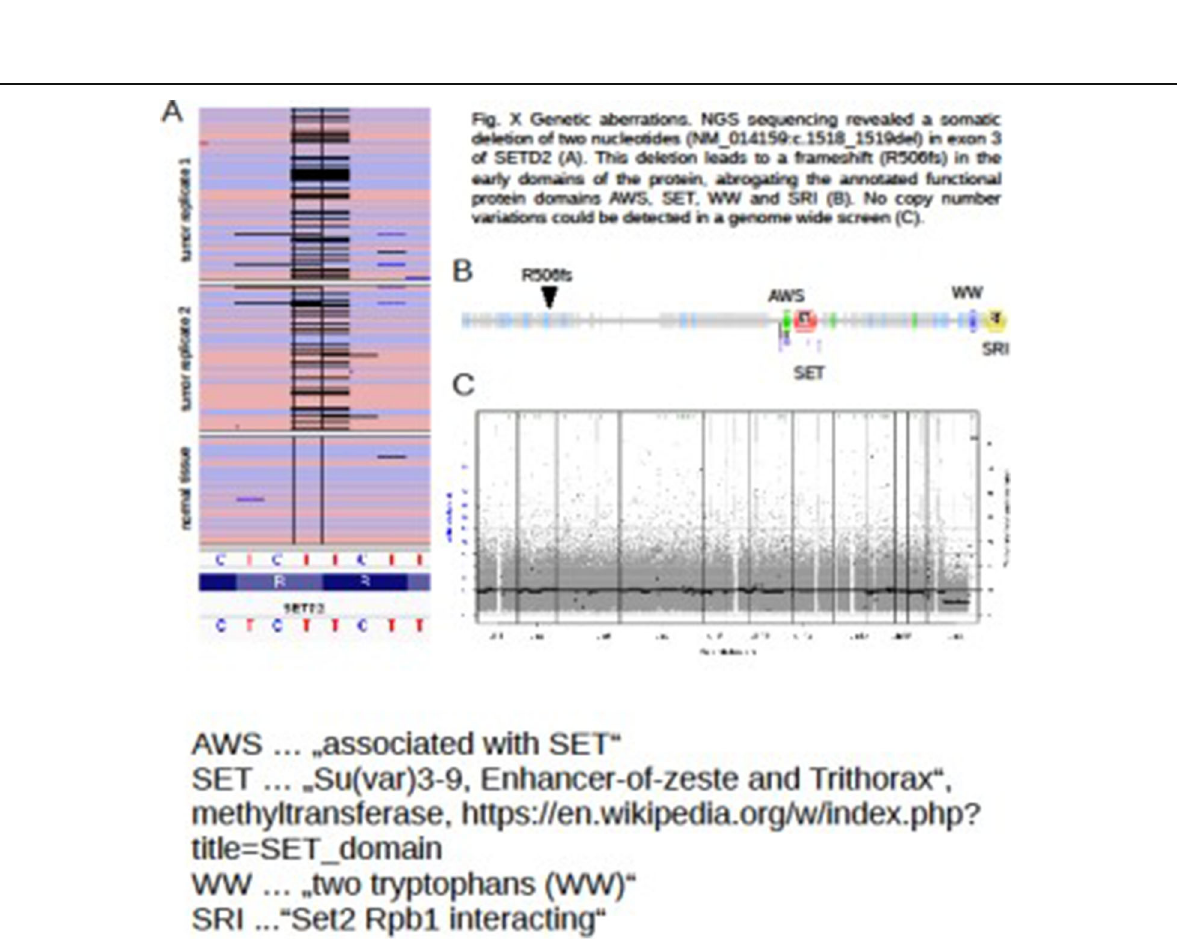
Fig. 8 Genetic aberrations. NGS sequencing revealed a somatic deletion of two nucleotides in exon 3 of